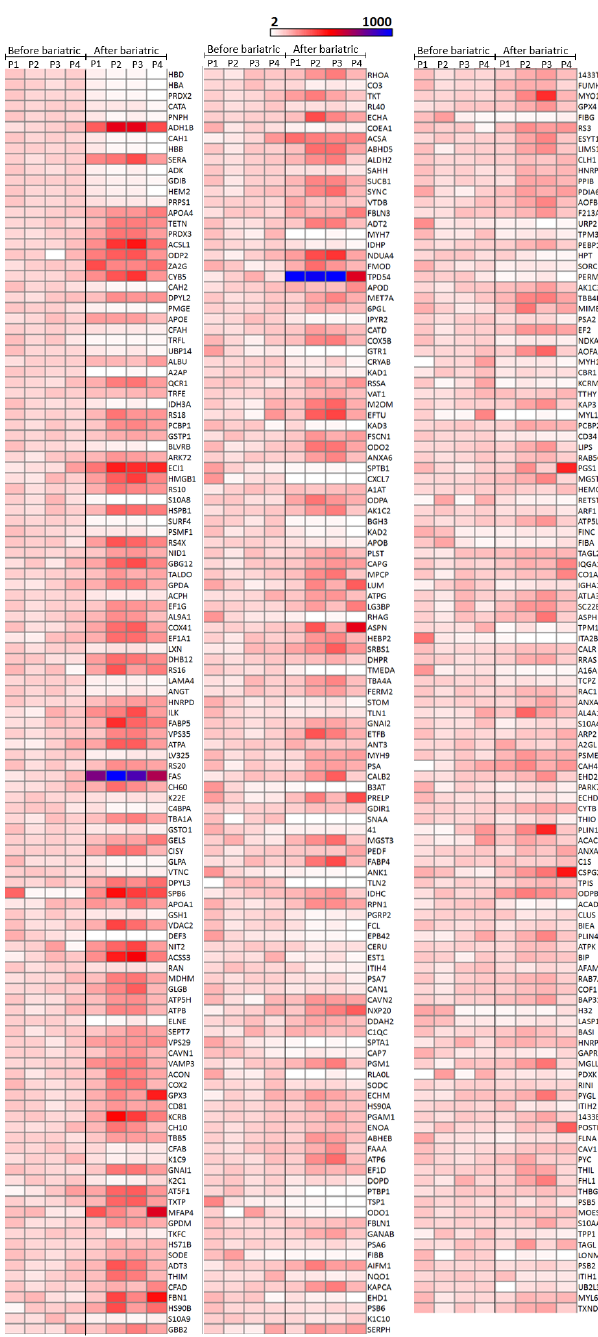
Figure 2. Heatmap of significantly regulated proteins by weight loss induced by bariatric surgery on aSAT using a sequential window acquisition of all theoretical mass spectra (SWATH-MS) technique. E ff ects of weight loss induced by bariatric surgery on aSAT protein expression. Three-hundred and sixty-four proteins were significantly regulated, 136 down-regulated and 228 up-regulated. The expression intensity of each protein varies from white to blue. The expression is given in arbitrary units and in order to adequately visualize the changes due to bariatric surgery, the expression value of each protein was normalized taking into account the mean of that protein for the four patients before undergoing bariatric surgery. This value was assigned as 100% and all values represented here were expressed based on that value. The proteins are ordered according to the p -value. In the first column, the p -value varied from 5.25E–12 to 5.47E–05, in the second column from 5.97E–05 to 0.00283, and in the third column from 0.00284 to 0.04071. A value of p < 0.05 was considered statistically significant. Data were plotted using matrix2png version 1.2.2 (http: // www.chibi.ubc.ca / matrix2png / ). P1–P4 = Patient 1–Patient